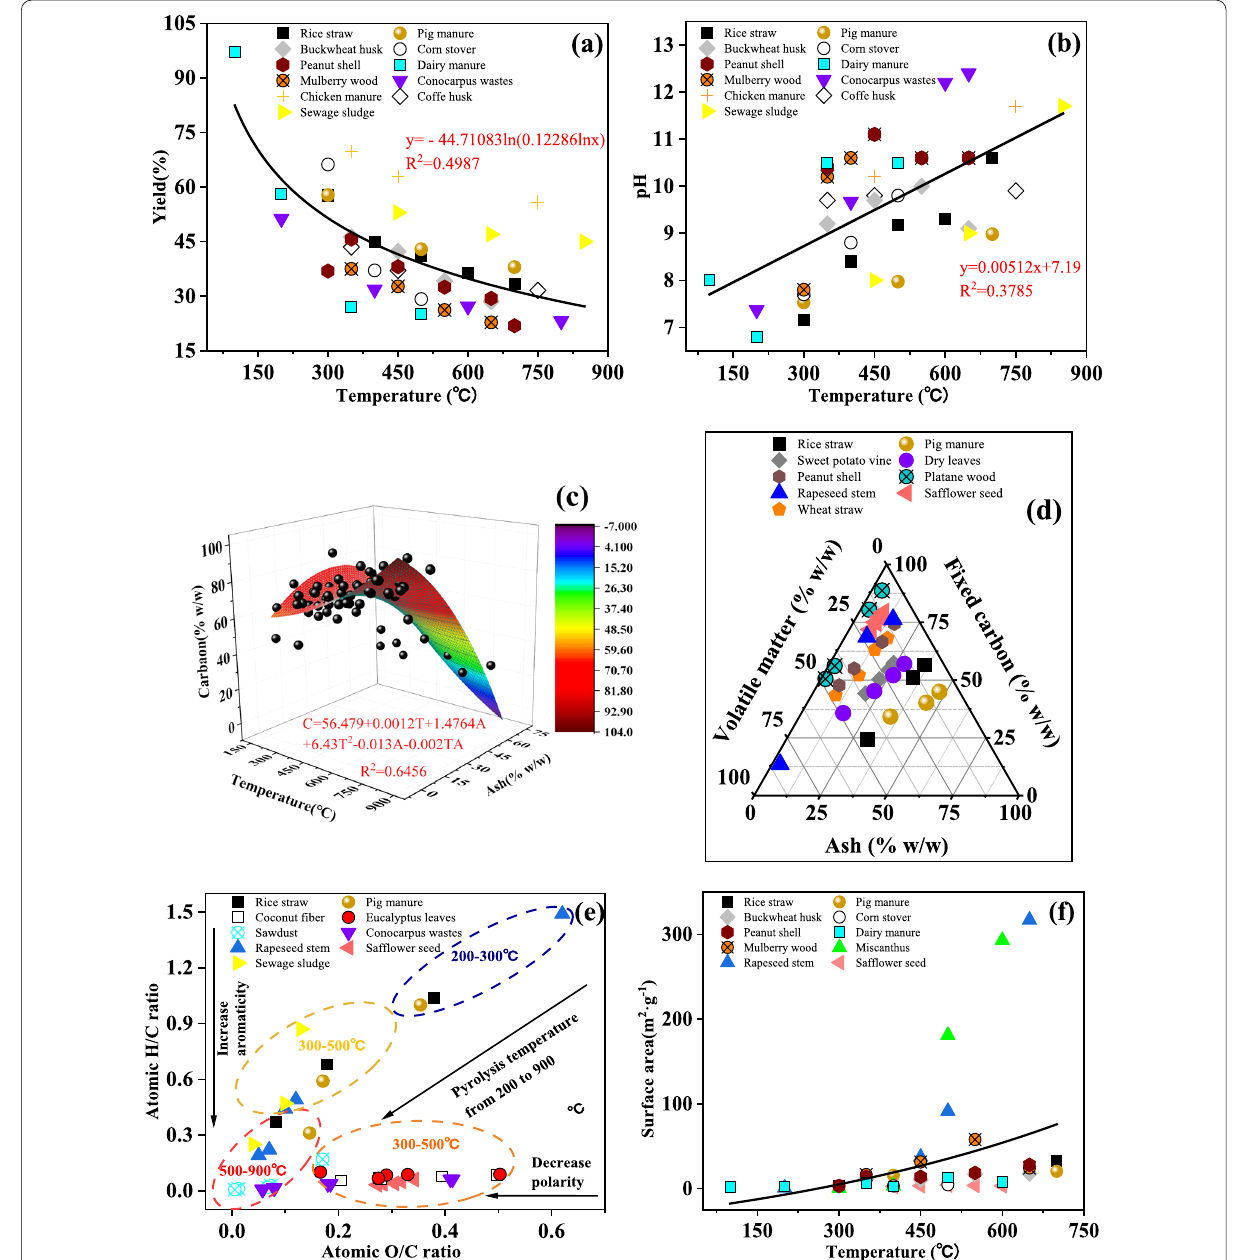
Fig. 1 Percent yields ( a ), pH ( b ), Van Krevelen diagram ( e ), surface area ( f ) of biochar from different feedstocks at different pyrolysis temperatures; Biochar total carbon content (% w/w) changes with peak pyrolysis temperature and ash content ( c ); Biochar ash, volatile matter, and fixed carbon proportions expressed as weight % in a ternary graph for each biochar type ( d ). [Data are from reference (Cha et al. 2016; Chandra and Bhattacharya 2019; Das et al. 2021; Liu et al. 2017b; Sun et al. 2017; Tomczyk et al. 2020; Xie et al. 2015; Zhao et al.